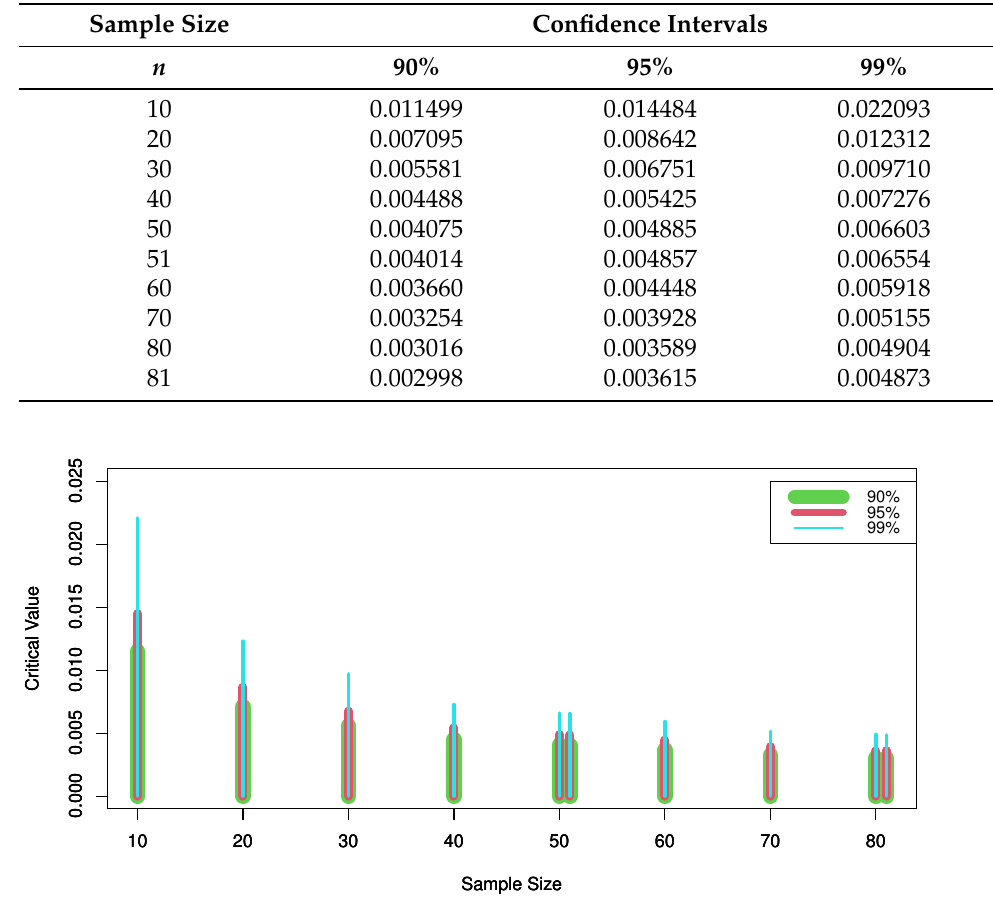
Figure 2. Relationship between the sample size, the level of confidence, and the critical values. ˆ ∆ ( s ) Test Power c